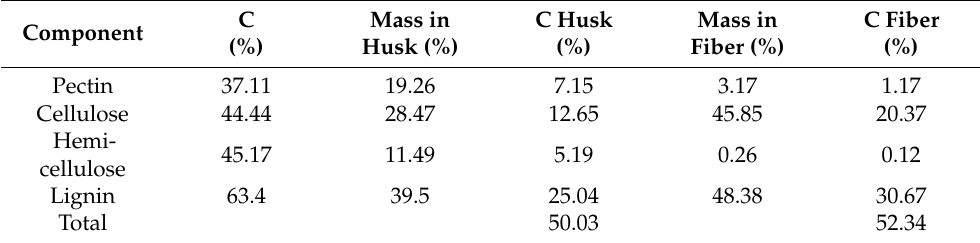
Table 5. Percentage of carbon in dry husk and fiber (discounting